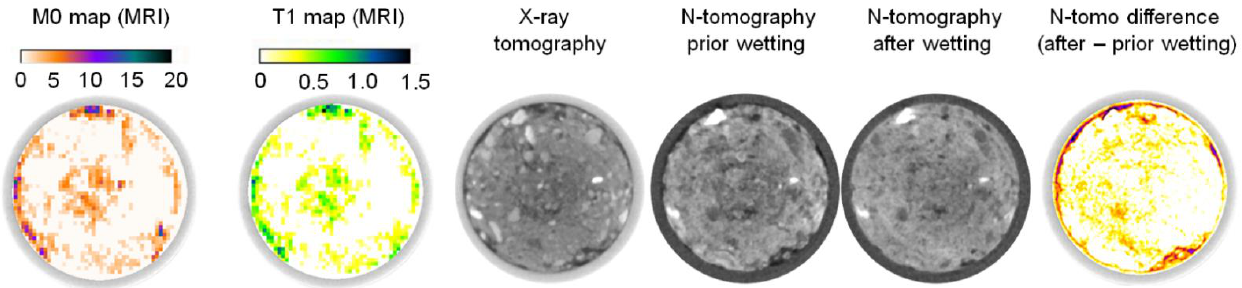
Figure 14. Soil sample investigated by tri-modal N/X/MRI imaging. (image courtesy of V. Jelinkova, [27]). The sample inner diameter equals 34 mm.